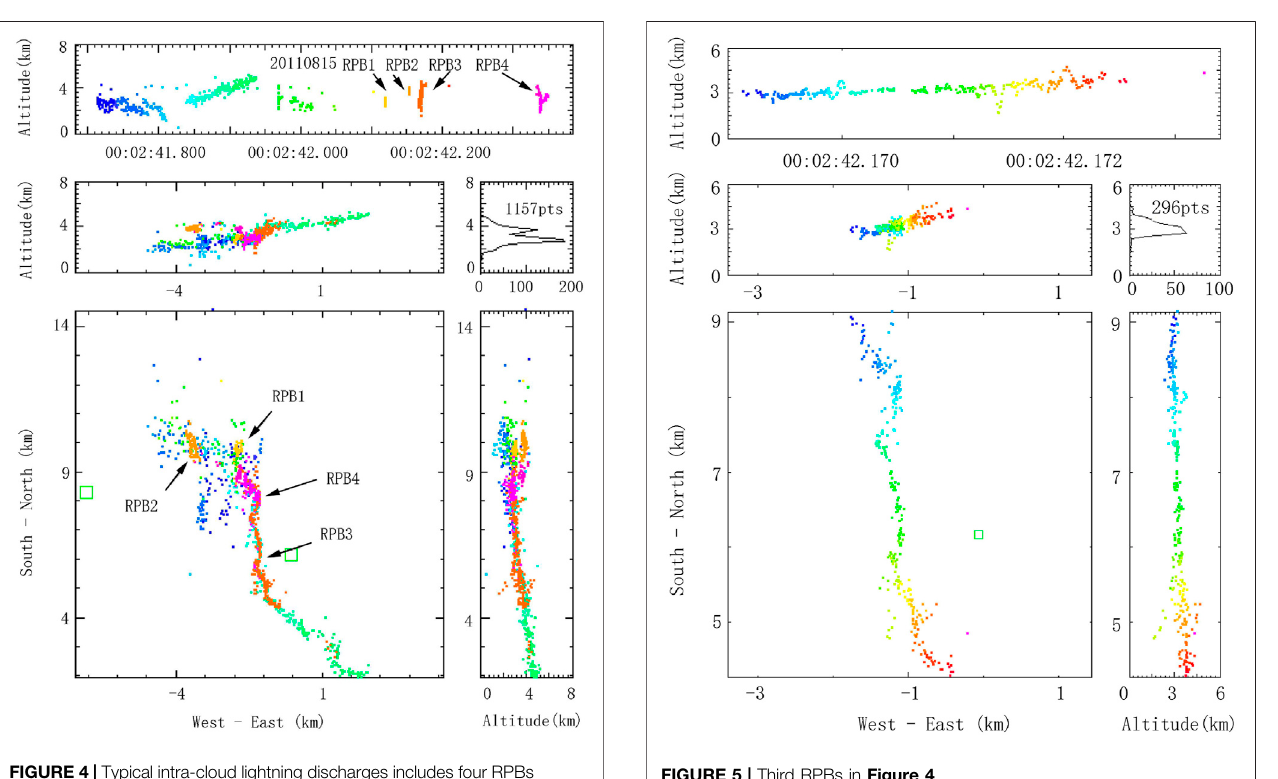
FIGURE 5 | Third RPBs in Figure 4